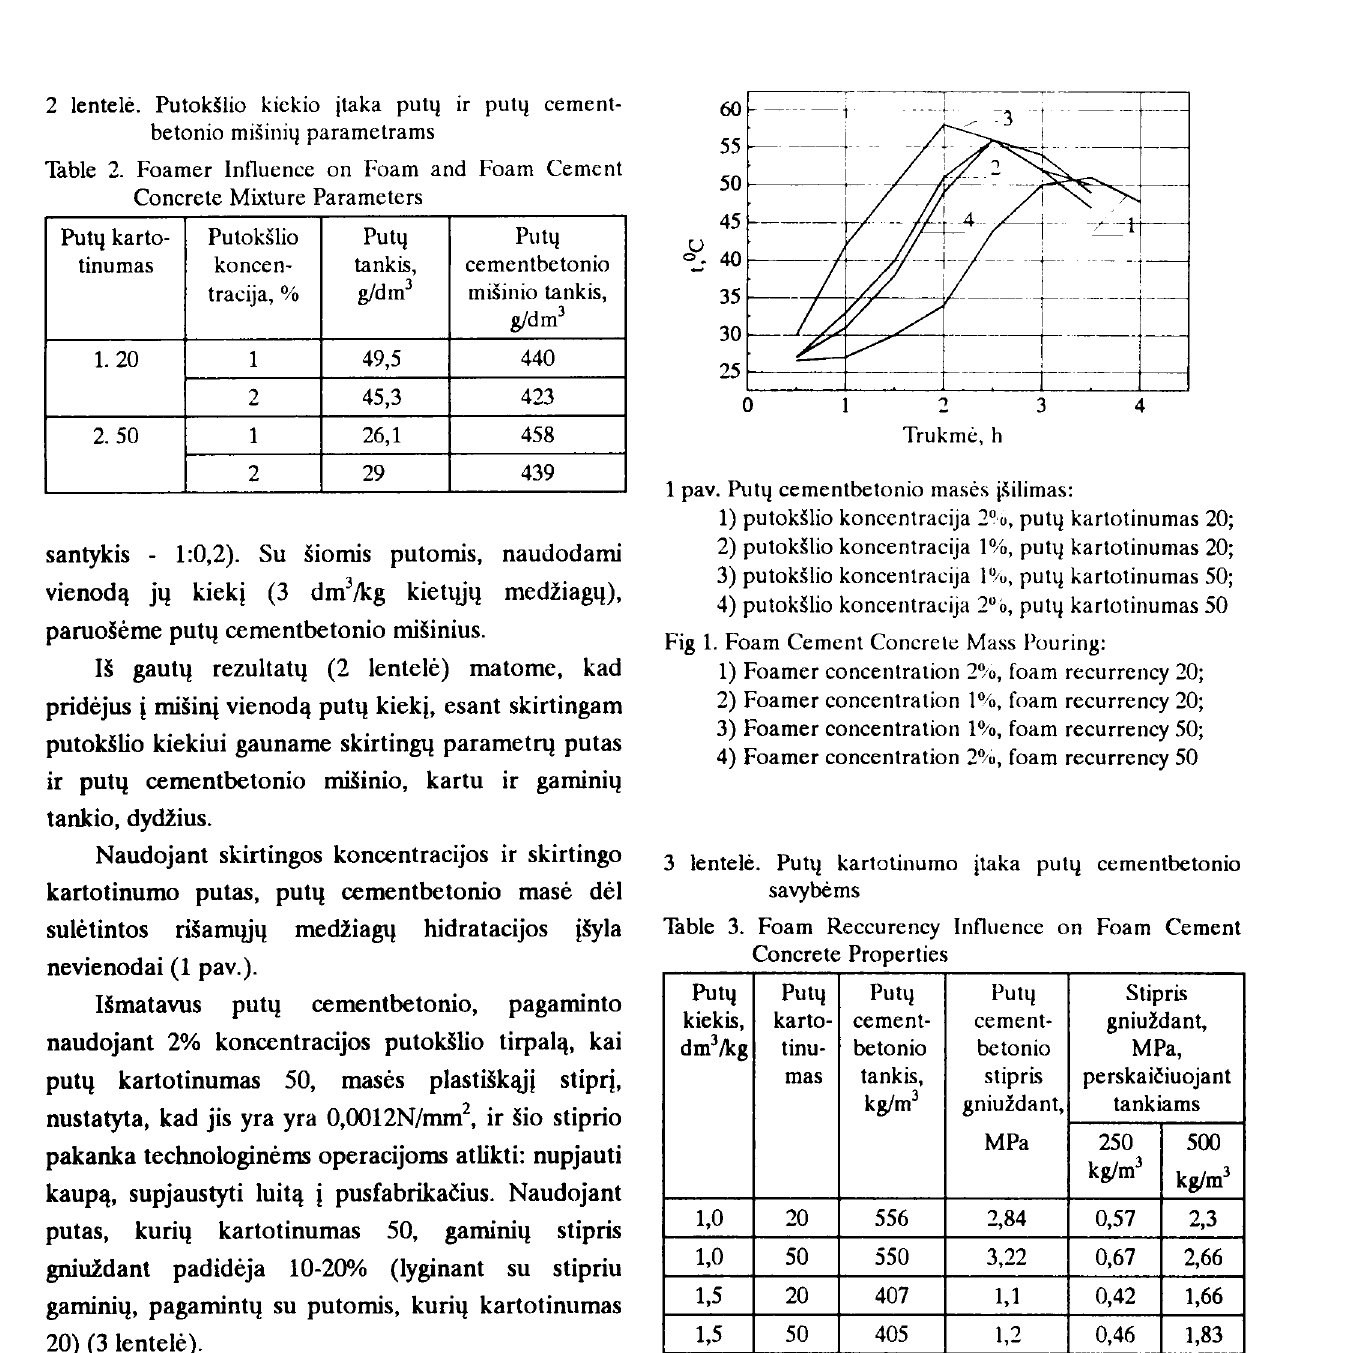
Fig 1. Foam Cement Concrete Mass Pouring: